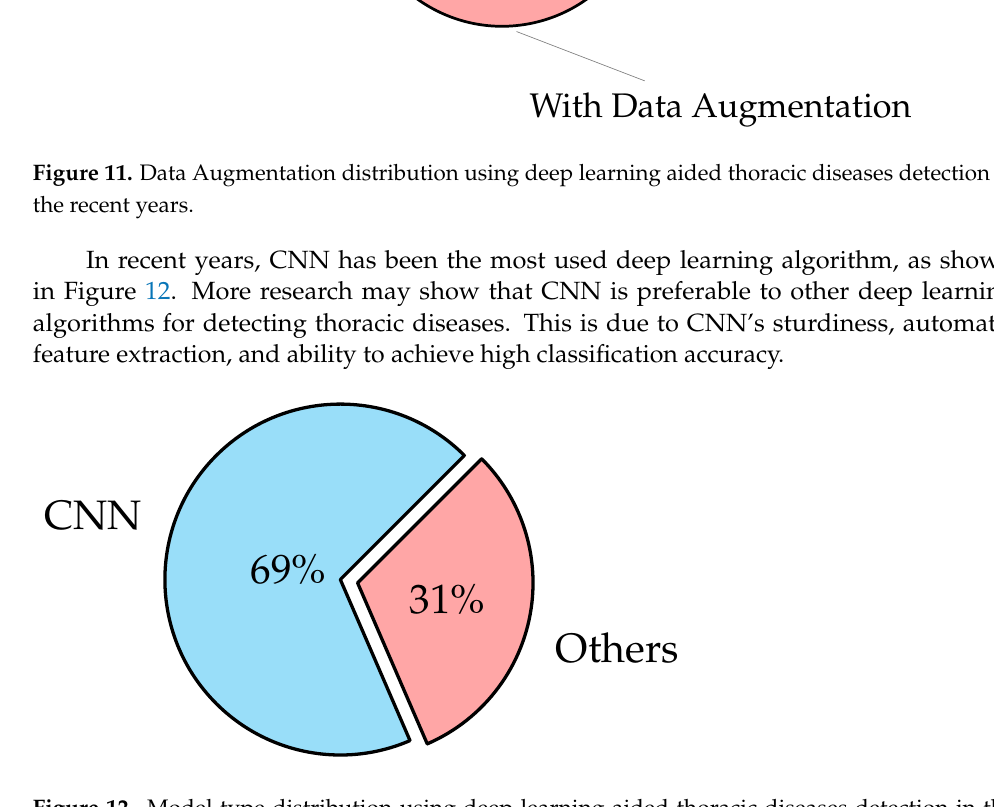
Figure 12. Model type distribution using deep learning aided thoracic diseases detection in the recent years.